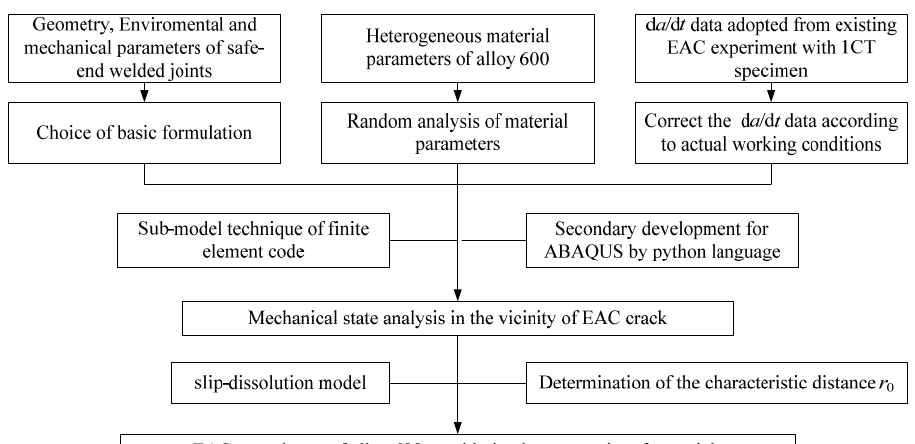
Figure 5. The framework of the prediction process.